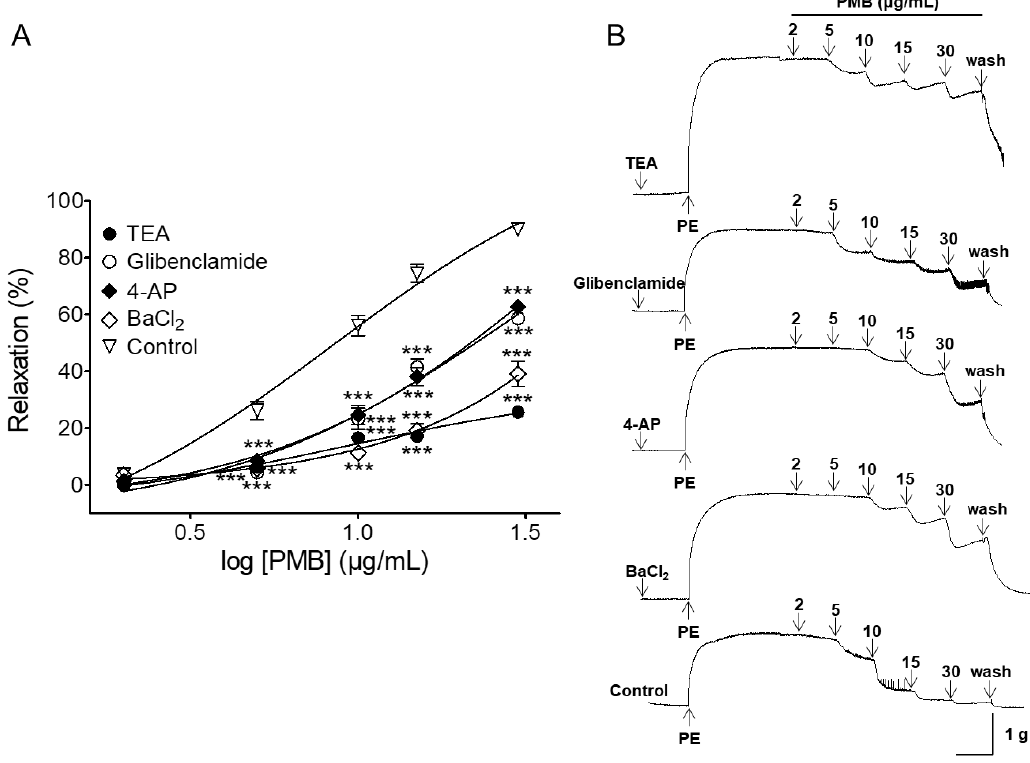
Figure 5. Relaxation responses induced by PMB (2–30 µ g / mL) on endothelium-intact aortic rings pre-contracted with phenylephrine (PE, 1 µ M) in the presence of tetraethylammonium (TEA, 5 mM), glibenclamide (10 µ M), 4-aminopyridine (4-AP, 1 mM), or BaCl 2 (30 µ M) ( A ). Representative traces under the indicated conditions ( B ). Values are expressed as mean ± SEM ( n = 6). *** p < 0.001 vs. control.